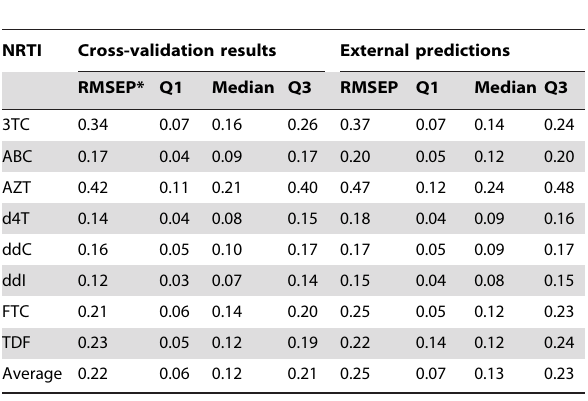
Table 2. Prediction errors for the eight NRTIs in proteochemometric model ( Model-3